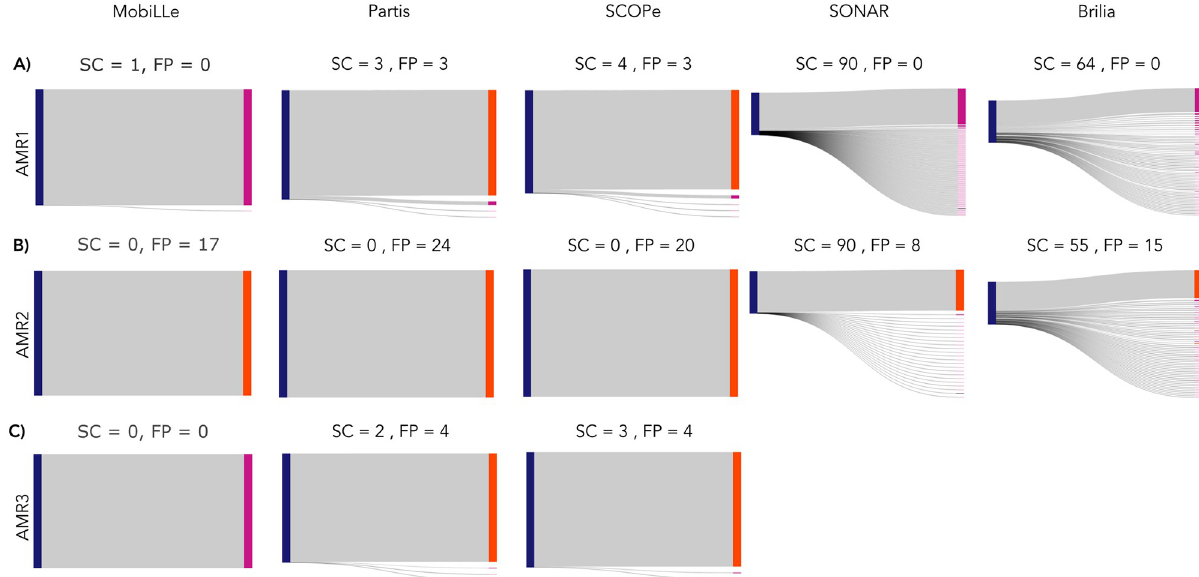
Fig 8. Performance comparison on artificial monoclonal repertoires. We generated three artificial monoclonal repertoires (AMR1, AMR2, and AMR3) by sampling sequences from a pure B cell lineage (10%) and a polyclonal background (90%). Each benchmark contained 10000 sequences. Accurate tools might group sequences from the pure B cell lineage and separate those from the polyclonal background. We measured the performance of BCR lineage grouping methods by computing the number of splits (SC) and false positives (FP) of the most abundant group. To better visualize and compare clustering results, we show alluvial diagrams for AMR1 (a), AMR2 (b), and AMR3 (c), where blue blocks represent the pure B cell lineage and pink or orange inferred groups. Pink blocks contain only sequences belonging to the pure B cell lineage (true positives), while the orange blocks contain sequences from the polyclonal background (false positives). SONAR and BRILIA did not produce results for the AMR3 benchmarks since they do not deal with non-productive